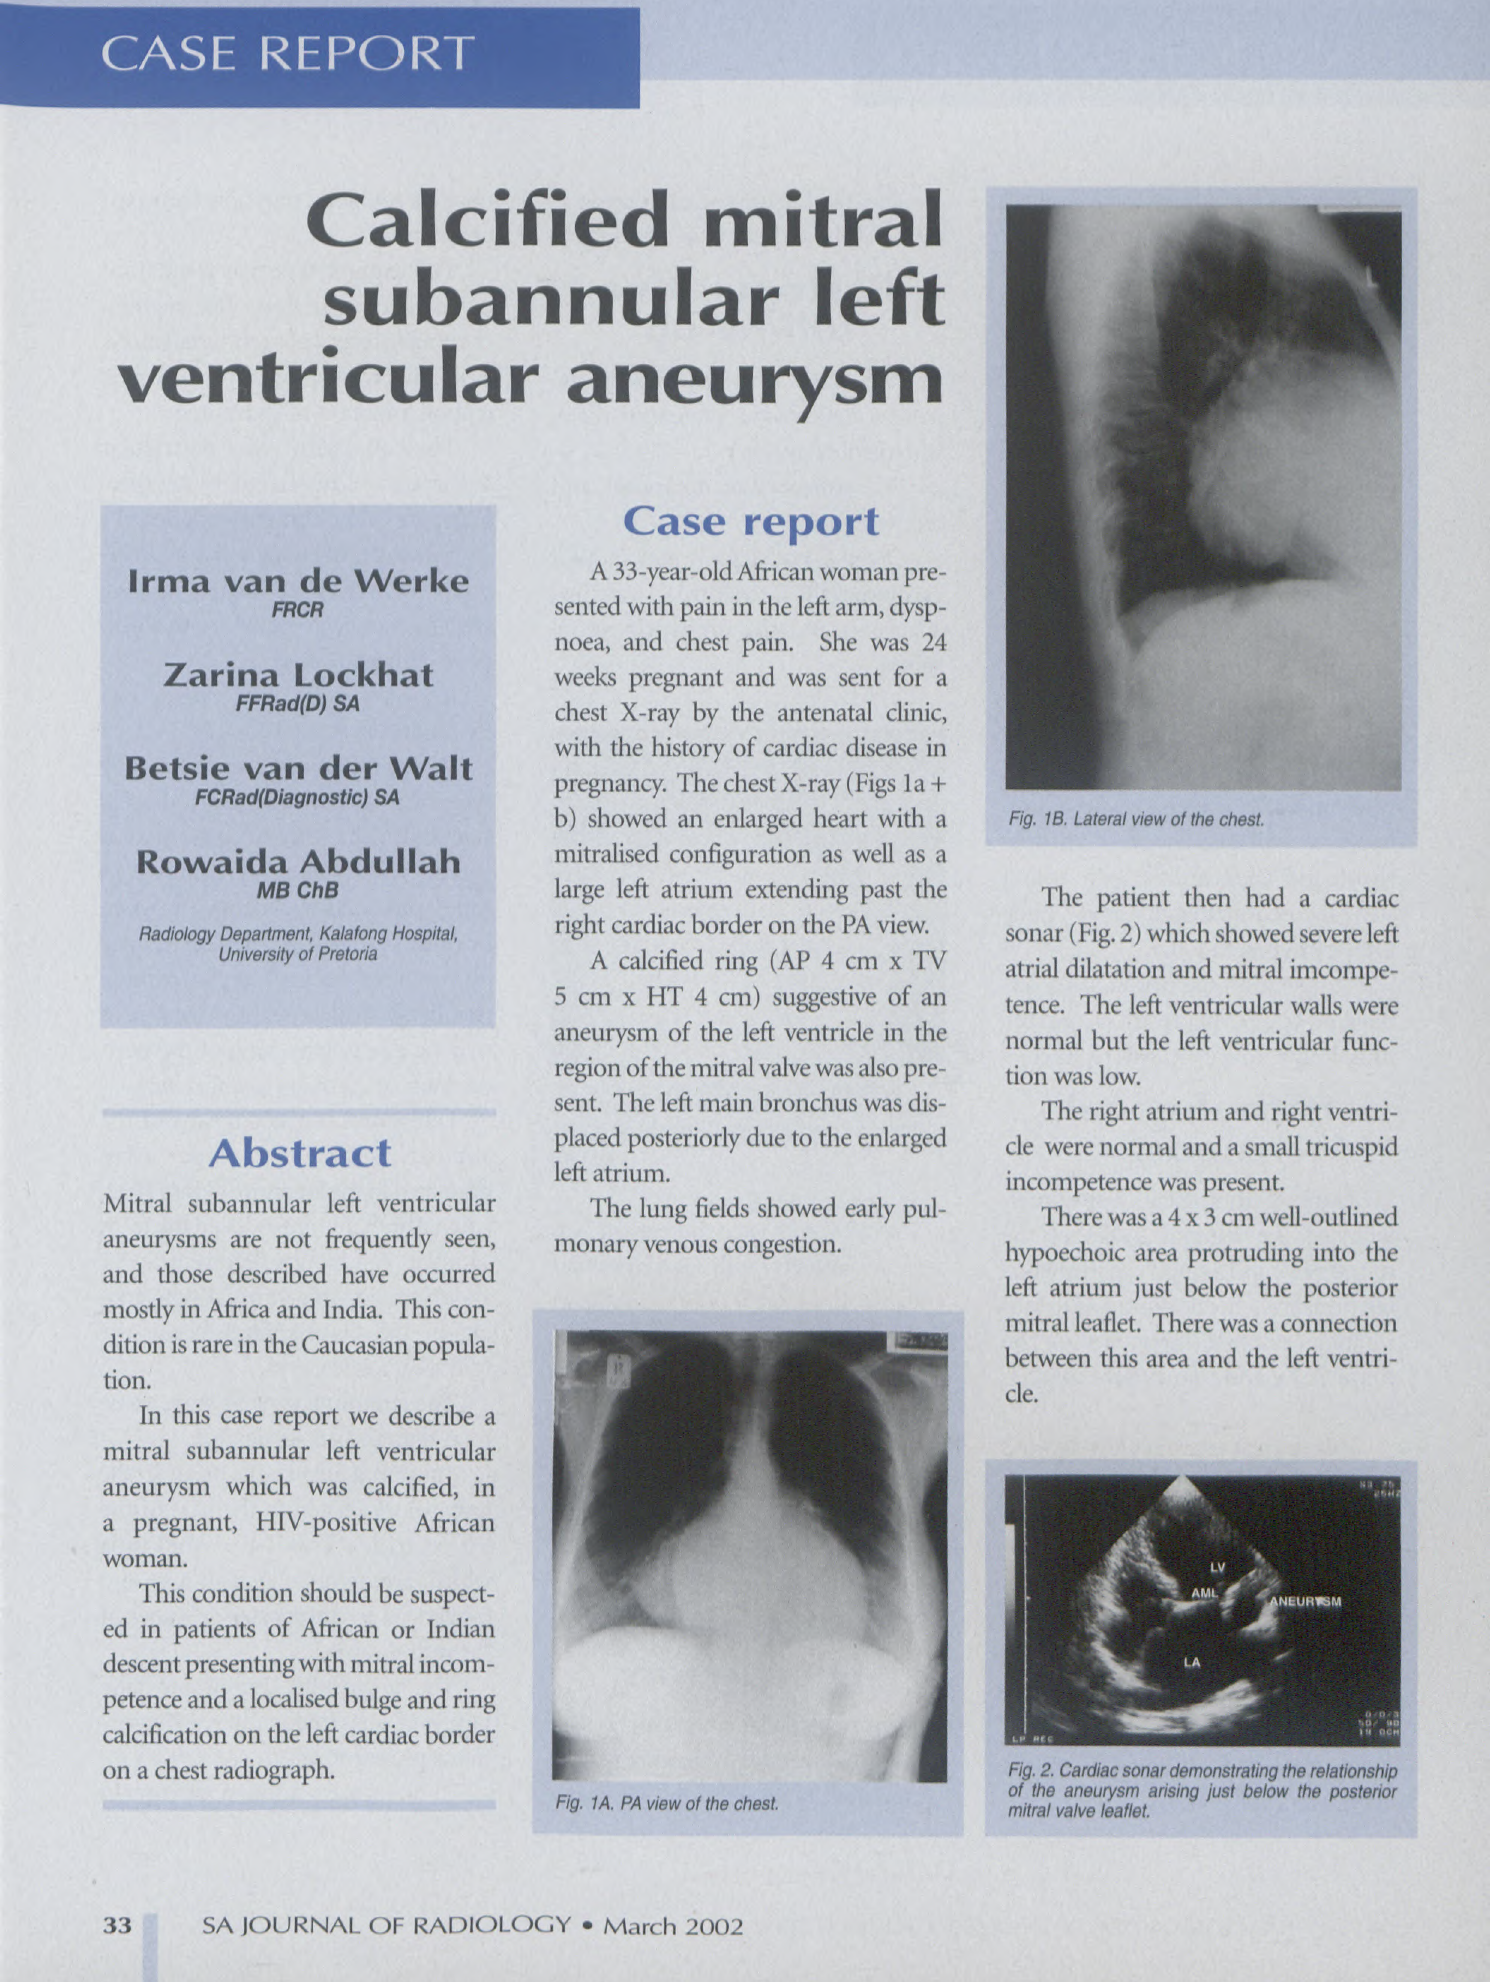
Fig. 1A. PA view of the chest.